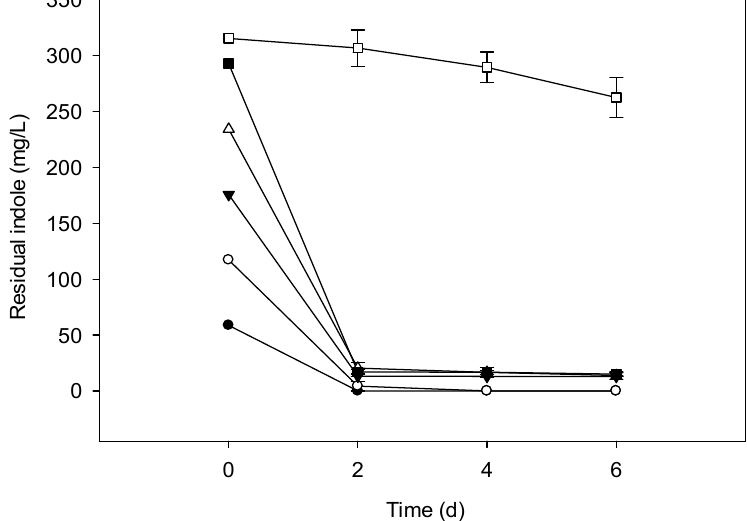
Figure 2. Indole removal capability of TAT1-6A strain at different initial concentrations (mg/L). Symbols: Solid circle, 58.58; open circle, 117.15; solid triangle, 175.73; open triangle, 234.30; solid square, 292.87; open square, 351.45; error bars, mean ± SE of three replicates at 31 °C and pH 6.